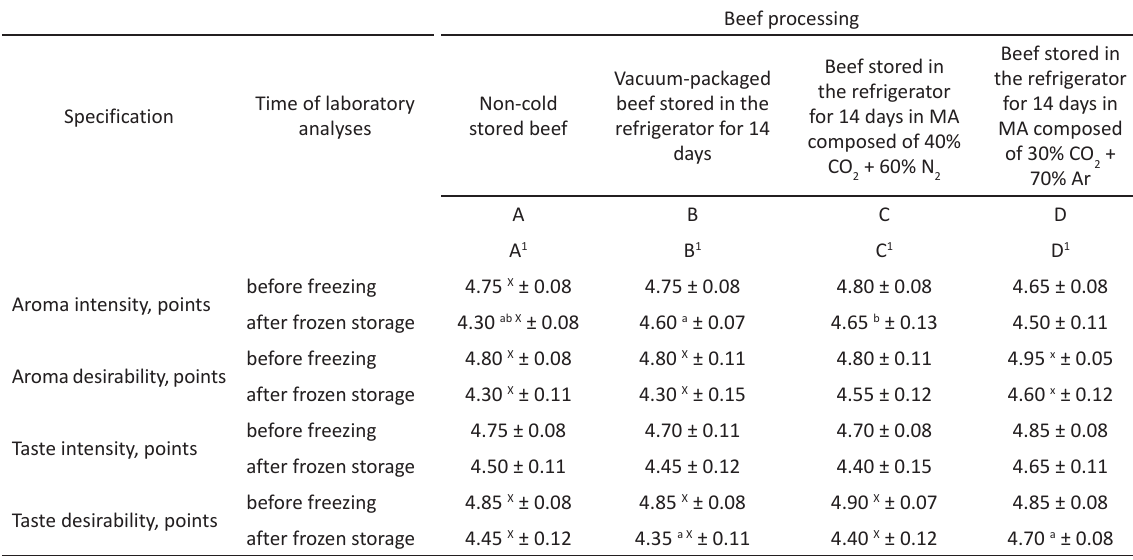
Table 4. Aroma and taste of meat